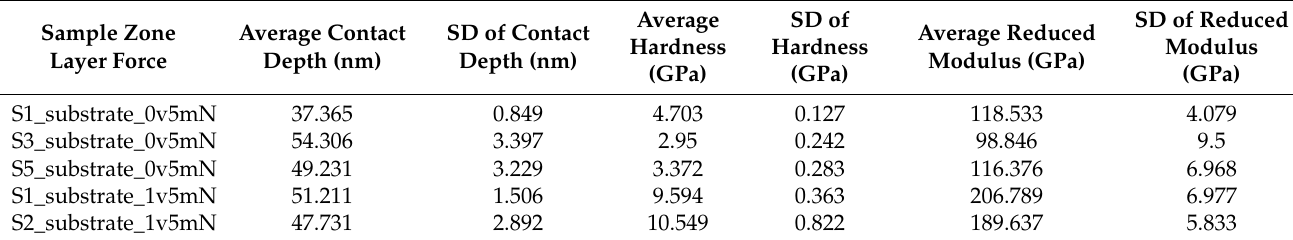
Table 2. Hardness values and modulus of elasticity calculated for thin film and for Co-Cr base layer using nanoindenta- tion